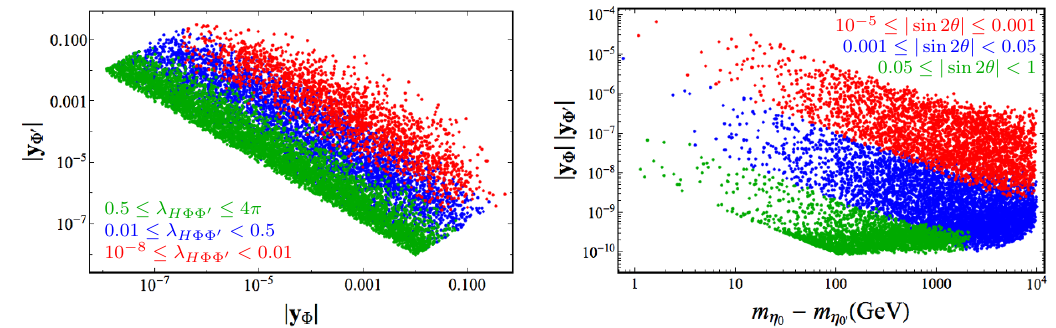
Figure 9 . Left panel: the mass splitting of the new neutral scalars m (cid:17)